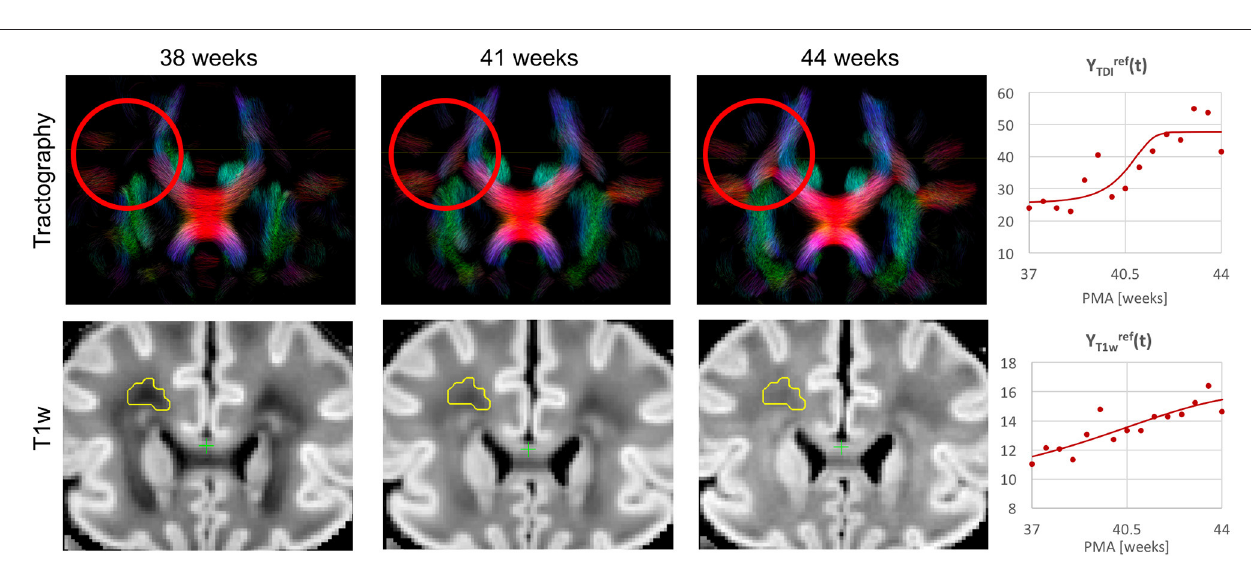
FIGURE 9 | Comparison of the Gompertz function and linear fitting results in terms of R 2 values evaluated within the combined WM and γ av parcellation map regions (A) and frontal Von Monakow WM regions (B) . The results are statistically significant with p < 0.001.